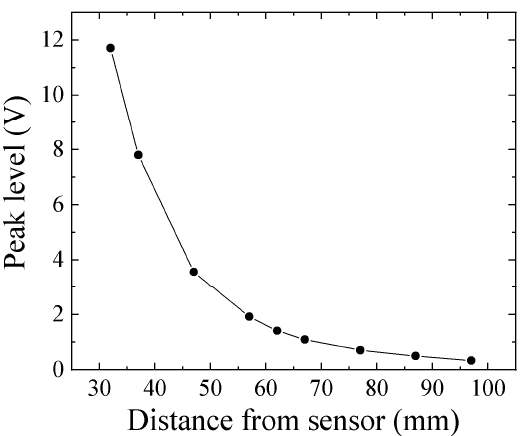
Figure 18. Dependence of sensor output voltage on tool steel chipping height.